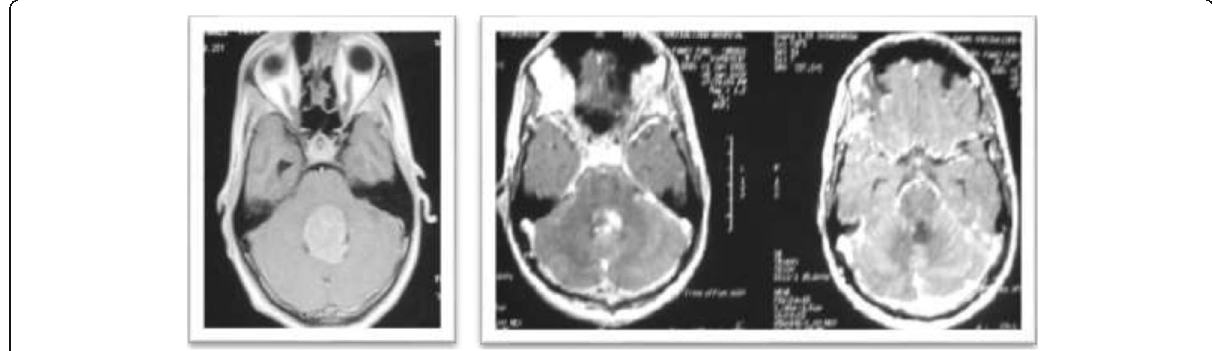
Fig. 4 (Left) Pre-op MRI brain axial cuts with contrast shows fourth ventricular mass (fourth ventricular choroid plexus papilloma) with homogenous enhancement operated via transvermian approach. (Right) Near total resection was achieved through telovelar approach with small residual on the fourth ventricular floor.